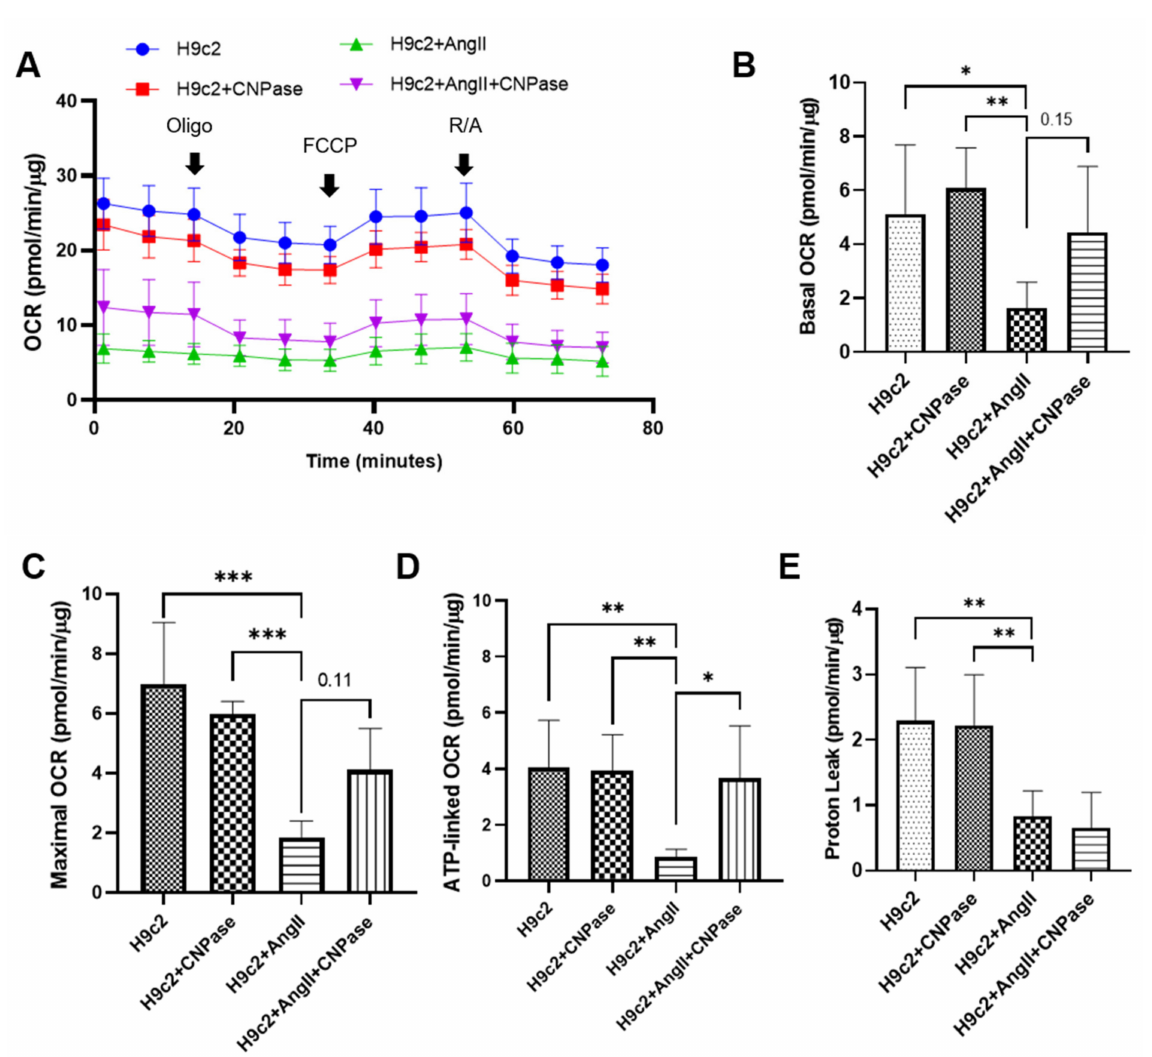
Figure 6. CNPase expression is essential for mitochondrial integrity, respiration capacity, and ATP production. ( A ) The general scheme of the mitochondrial stress test. The mitoStress assay was carried out on a Seahorse XFp extracellular flux analyzer (Agilent, Santa Clara, CA, USA) to directly measure the oxygen consumption rate (OCR) of cells. H9C2 cells were plated at a density of 2000 cells/well onto a 96-well seahorse microplate and transfected with pcDNA3.1-HA or pcDNA3.1-HA-CNPase vectors. For the mitoStress assay, programmable injection of selective inhibitors, oligomycin (2.5 µ M), FCCP (1 µ M), and rotenone/antimycin (2.5 µ M) was performed. The Seahorse data shown are acquired from 8–12 independent replicates per experiment. Oligo, Oligomycin; FCCP, Potent uncoupler of mitochondrial oxidative phosphorylation; R/A, Rotenone/Antimycin. ( B – E ) Effects of CNPase overexpression on the basal, maximal and spare mitochondrial respiration, ATP production, and proton leak. One-way ANOVA, Tukey’s multiple comparisons test, *, p < 0.05; **, p < 0.005; ***, p <